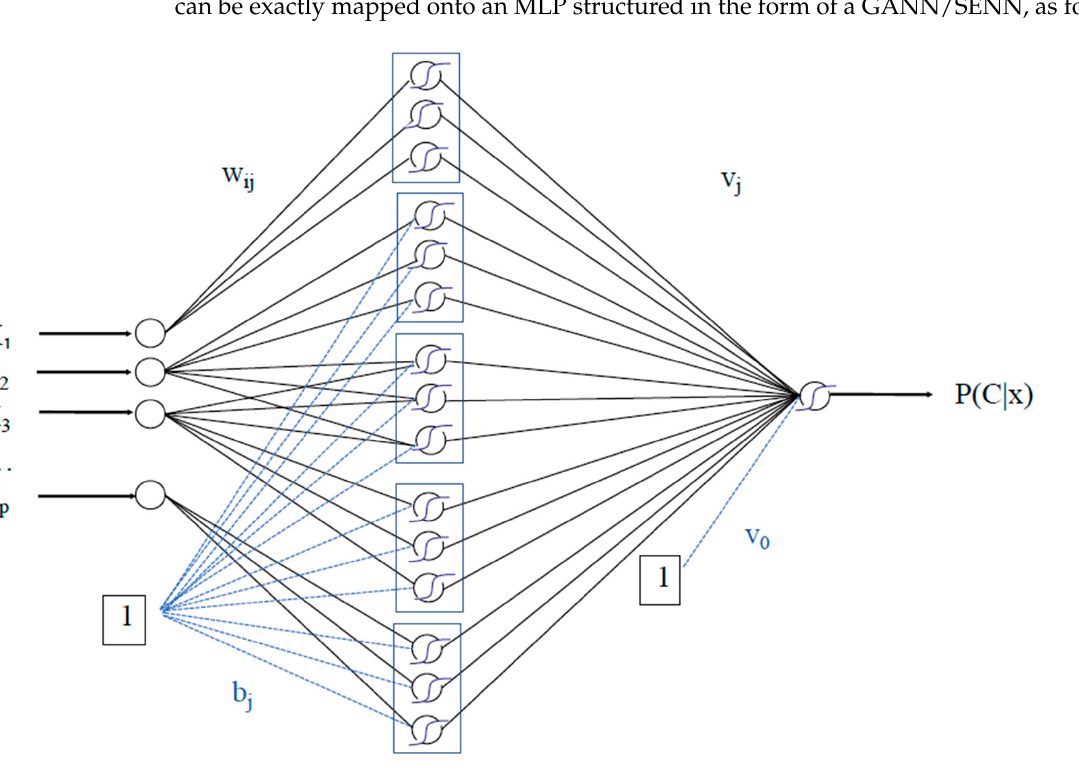
Figure 2. The partial response network (PRN) has the modular structure typical of a self-explaining neural network. In particular, the figure illustrates the connectivity for a univariate function of input variables x 1 and x p , and a bivariate term involving variables x 2 and x 3 . Modelling the interaction term as orthogonal to univariate terms involving the same variables requires three blocks of hidden nodes, as explained in the main text. If there are univariate additive component functions involving either x 2 or x 3 these are added to the structure by inserting additional modules, as shown for x 1 and x p .